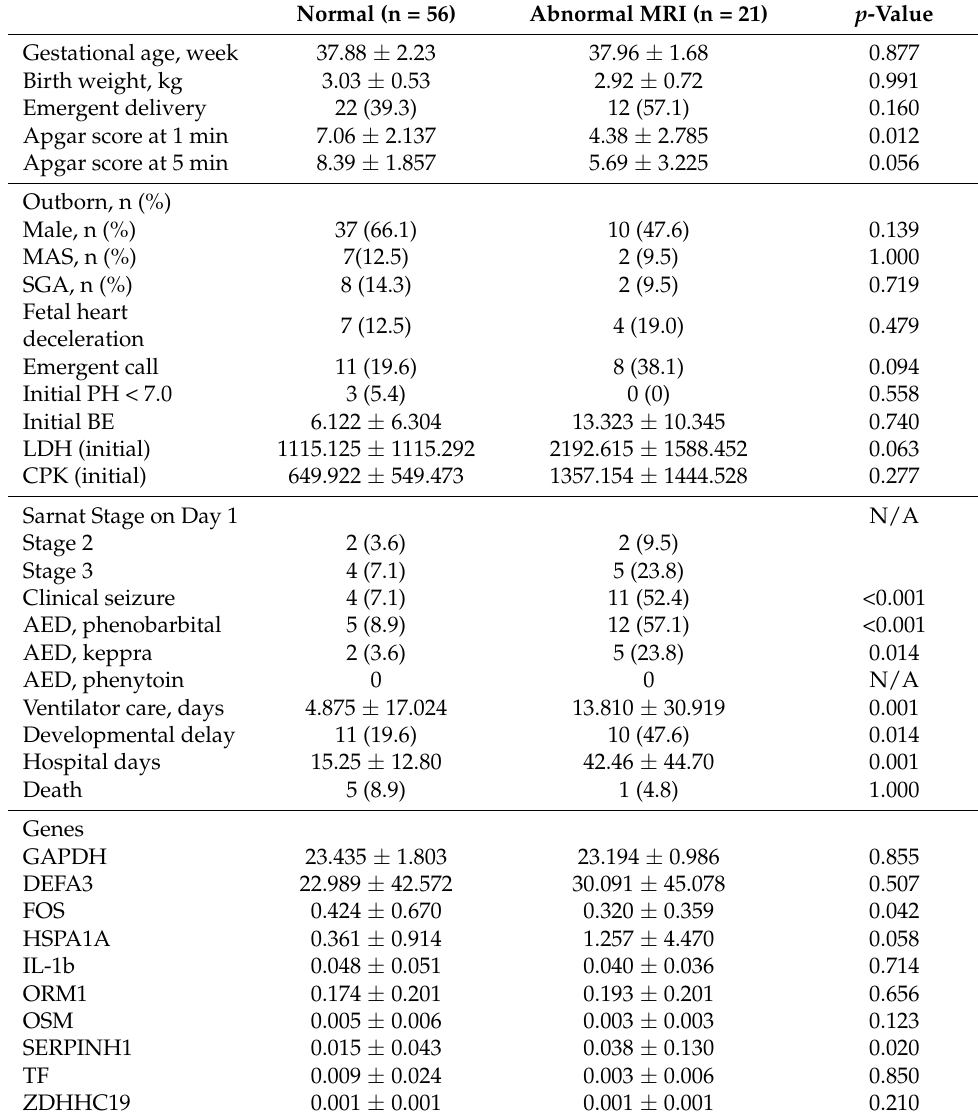
Table 3. Significant clinical findings in abnormal brain MRI (n =